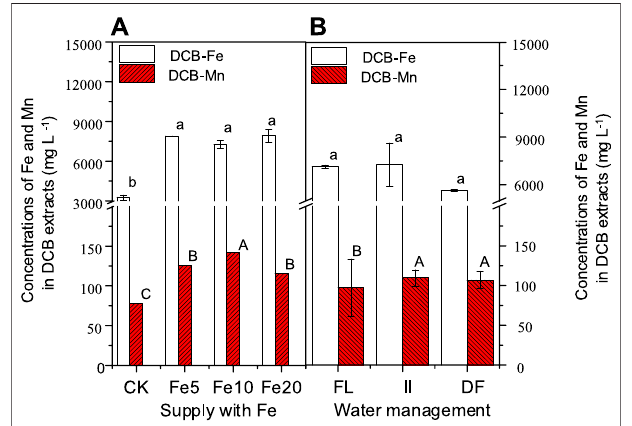
FIGURE 2 | Effects of FeCl 3 and water management on the formation of iron/manganese plaques. Bars are means and standard deviations for three replications. Different lowercase letters, capital letters, denote signi fi cant differences (at p ≤ 0.05) for Fe and Mn concentrations in the DCB extracts among different treatments, respectively.